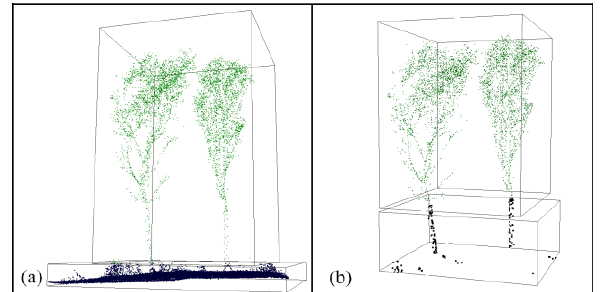
Figure 3. Initial classifications for trunk class extraction